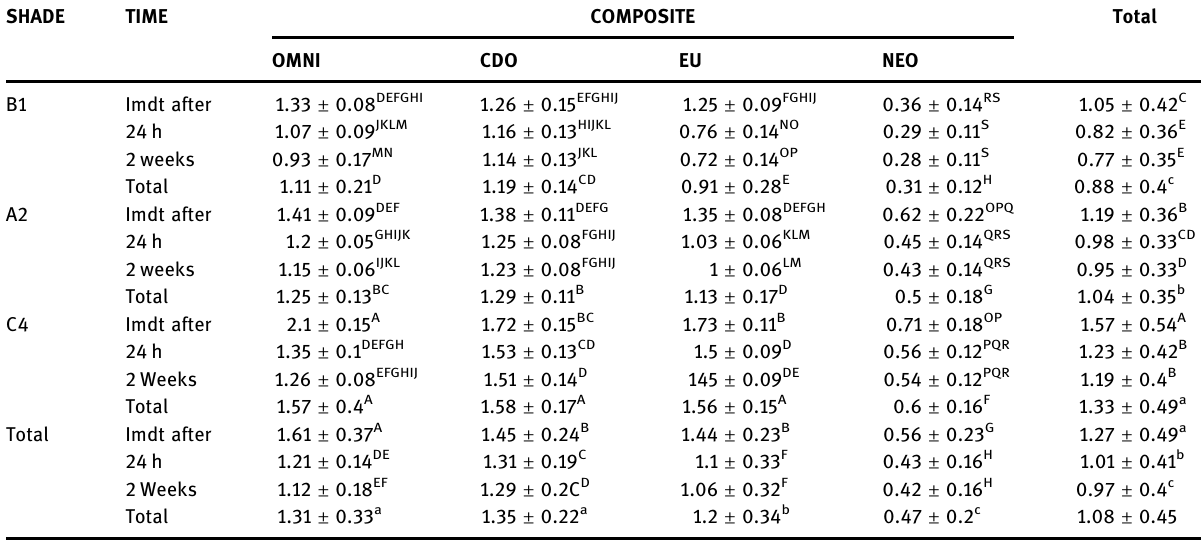
Table 3: Multiple variations anova of the Δ E 00 values, in terms of composite type, shade, and time SHADE